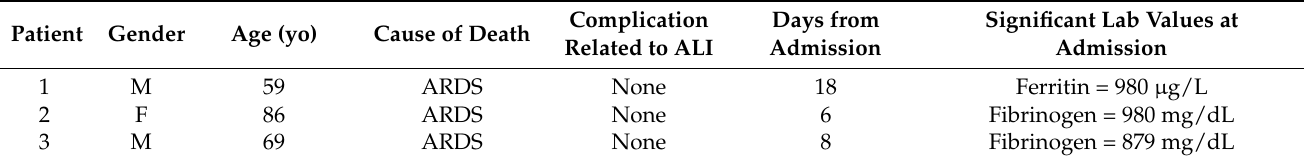
Table 3. Mortality